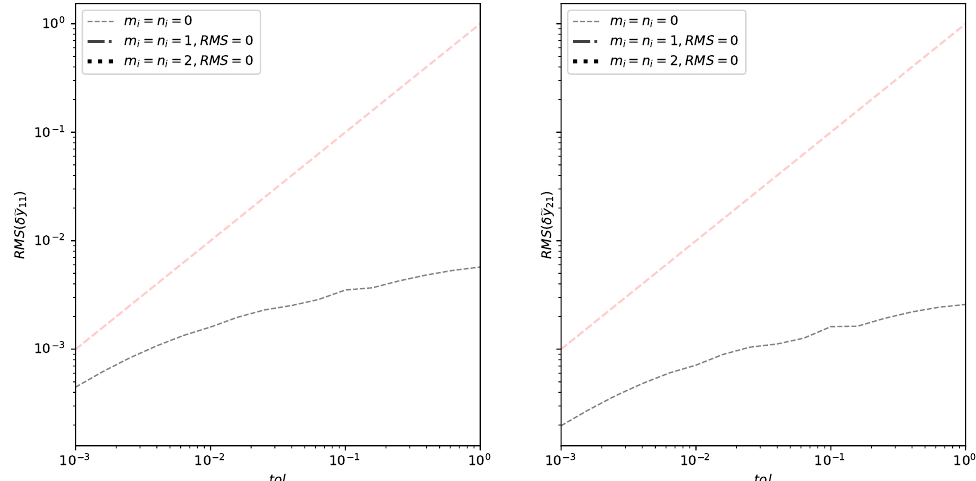
Figure 7. The diagrams show the output defects of the variable-step Jacobi co-simulation method (Algorithm 1, (39) and (50), H 1 = 10 − 4 ) and different orders of interpolation